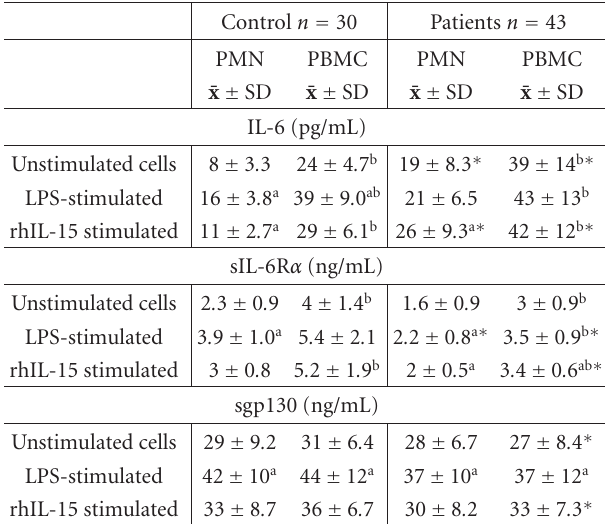
Table 1: IL-1 β , sIL-1RII, and IL-1Ra in the culture supernatants of PMN and PBMC from control and patients with Lyme disease.